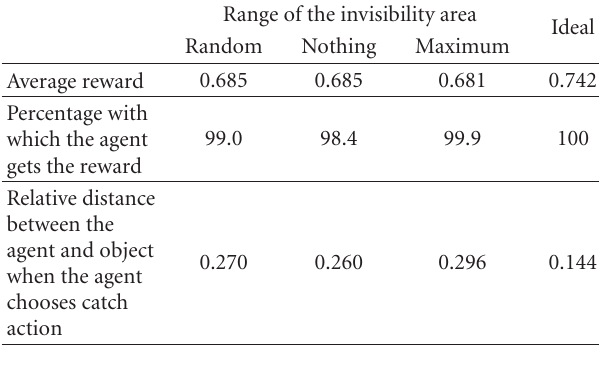
Table 1: The agent’s ideal and actual performance after learning for three cases of invisibility area.